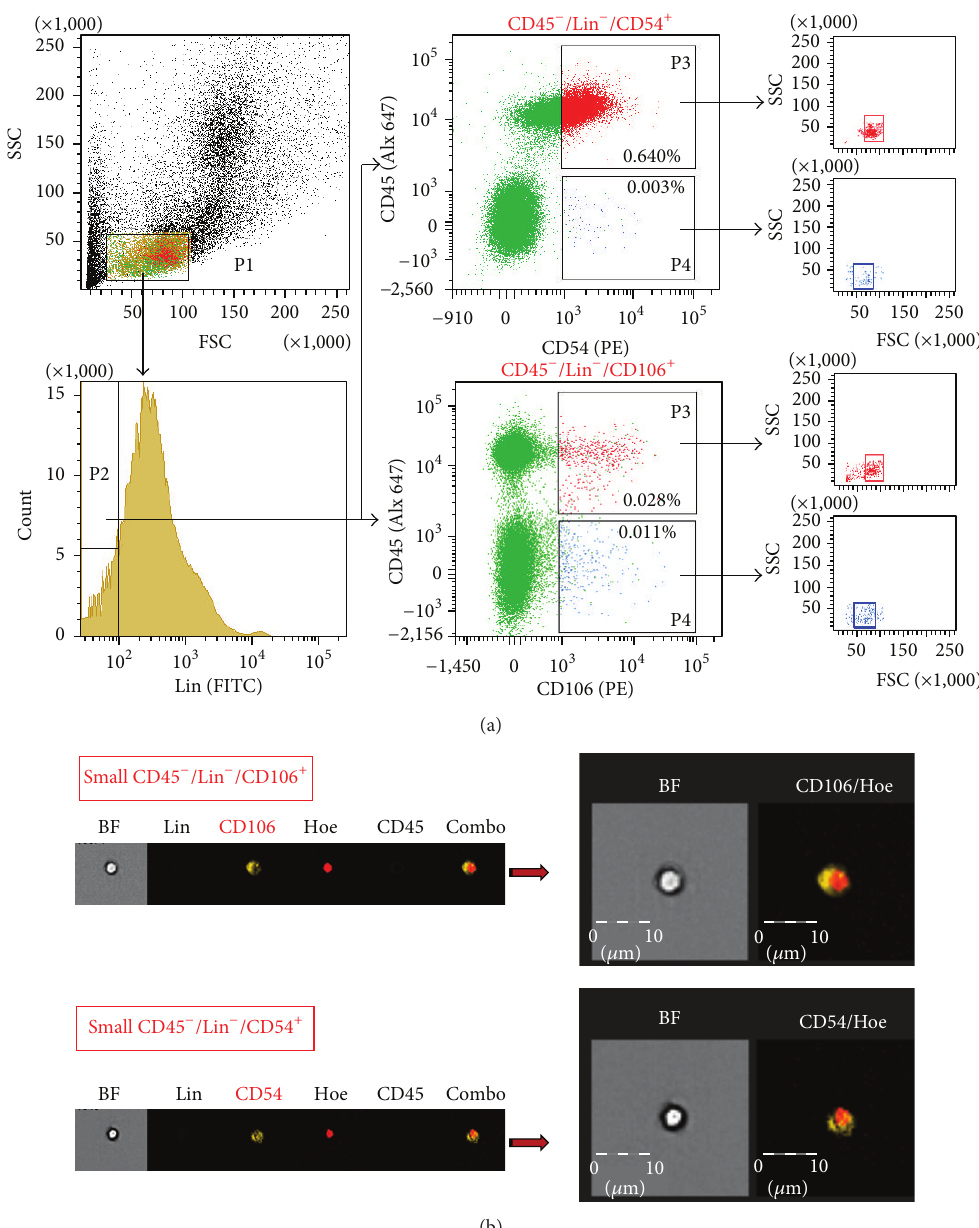
Figure 1: Expression of CD54 (ICAM-I) and CD106 (VCAM-I) on rat BM cells. (a) Gating strategy for identification of CD54 + and CD106 +